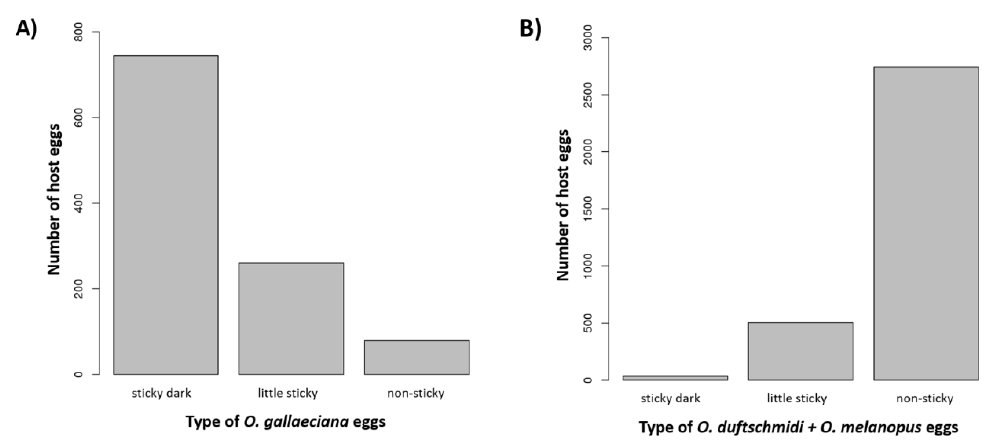
Figure 2. The graphs show the prevalence of three types of host eggs for O. gallaeciana ( A ) and O. duftschmidi + O. melanopus ( B ) from Czech Republic. 199